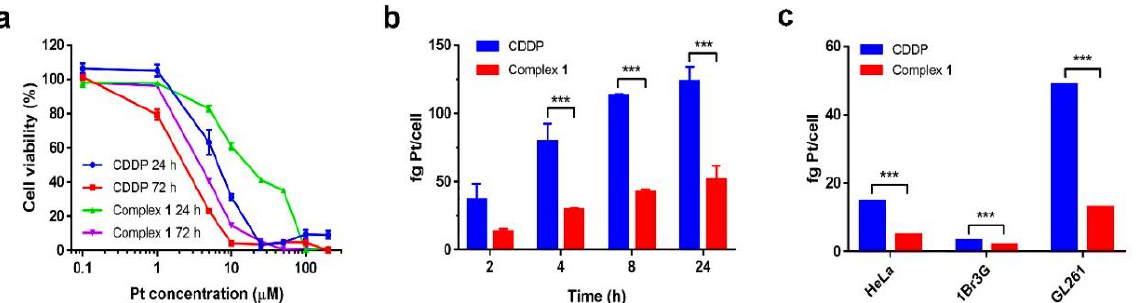
Figure 2. ( a ) Representative cytotoxicity of cisplatin (CDDP) and complex 1 against GL261 cells for 24 h and 72 h. ( b ) Cellular uptake of CDDP and complex 1 at different time points in GL261 cell, with a Pt concentration of 10 µ M. ( c ) DNA-bound Pt in different cell lines after exposure to 10 µ M Pt for 24 h. All data represent mean ± SE of three independent experiments. *** for p <